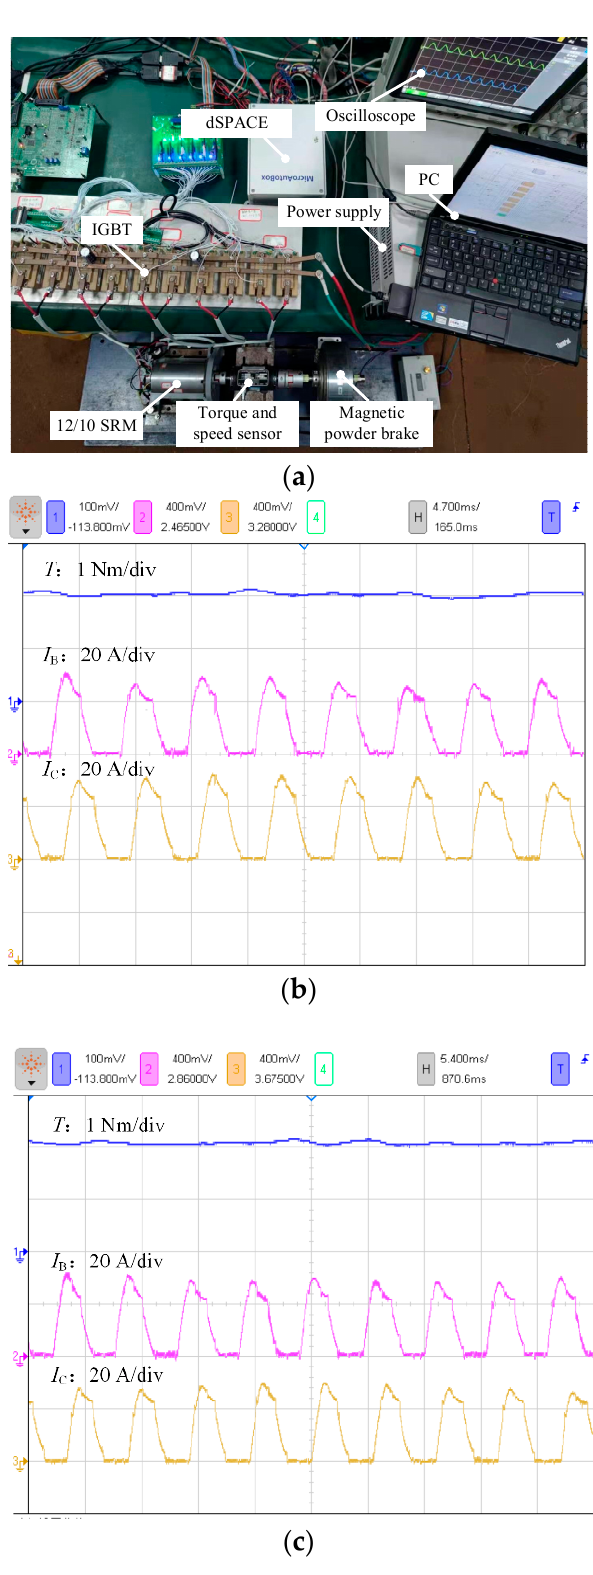
Figure 9. Experimental platform and results. ( a ) Test platform, ( b ) traditional symmetrical control, and ( c ) proposed asymmetric control.